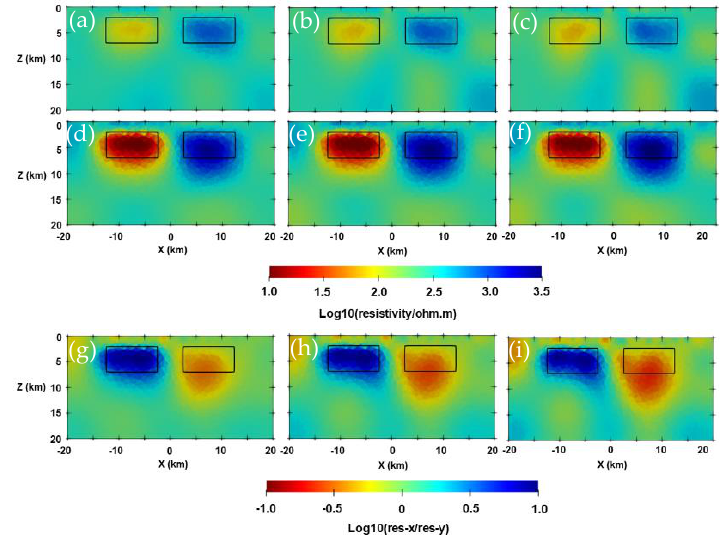
Figure A7. Anisotropic inversion results at y = 0 km. Panels ( a ) – ( c ) show the inverted resistivity in the principal X direction for 2%, 5%, 8% noise level. Panels ( d ) – ( f ) show the inverted resistivity in the principal Y direction for 2%, 5%, 8% noise level. Panels ( g ) – ( i ) show the inverted anisotropic coefficient for 2%, 5%, 8% noise level.